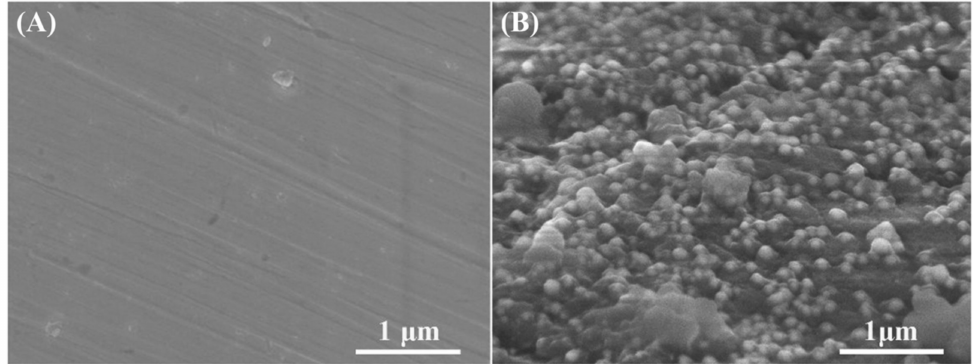
Figure 5. Field emission scanning electron microscope (FESEM) images of: ( A ) untreated; and ( B ) copper nanoparticles (Cu NPs) surface. Figure derived from the work of Cao et al. (Reproduced from [86], published by John Wiley and Sons, 2019.).